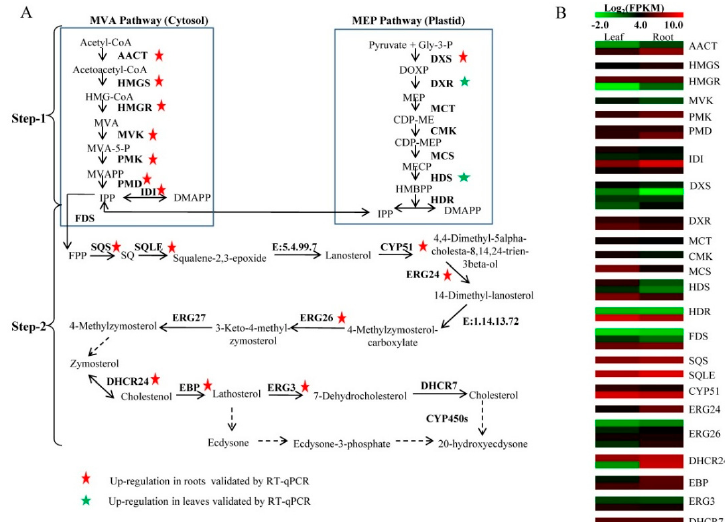
Figure 2. ( A ) The putative pathway of 20E biosynthesis in C. arachnoidea . ( B ) The gene expression was validated by RT-qPCR. The solid arrows denote known steps while the dashed arrows denote multi-step and incomplete reactions. Enzymes related to the different steps are shown between the reactions catalyzed. The expression level of unigenes related to these enzymes in leaf and root is shown by a heatmap. Names of the enzymes are provided in Table 3.